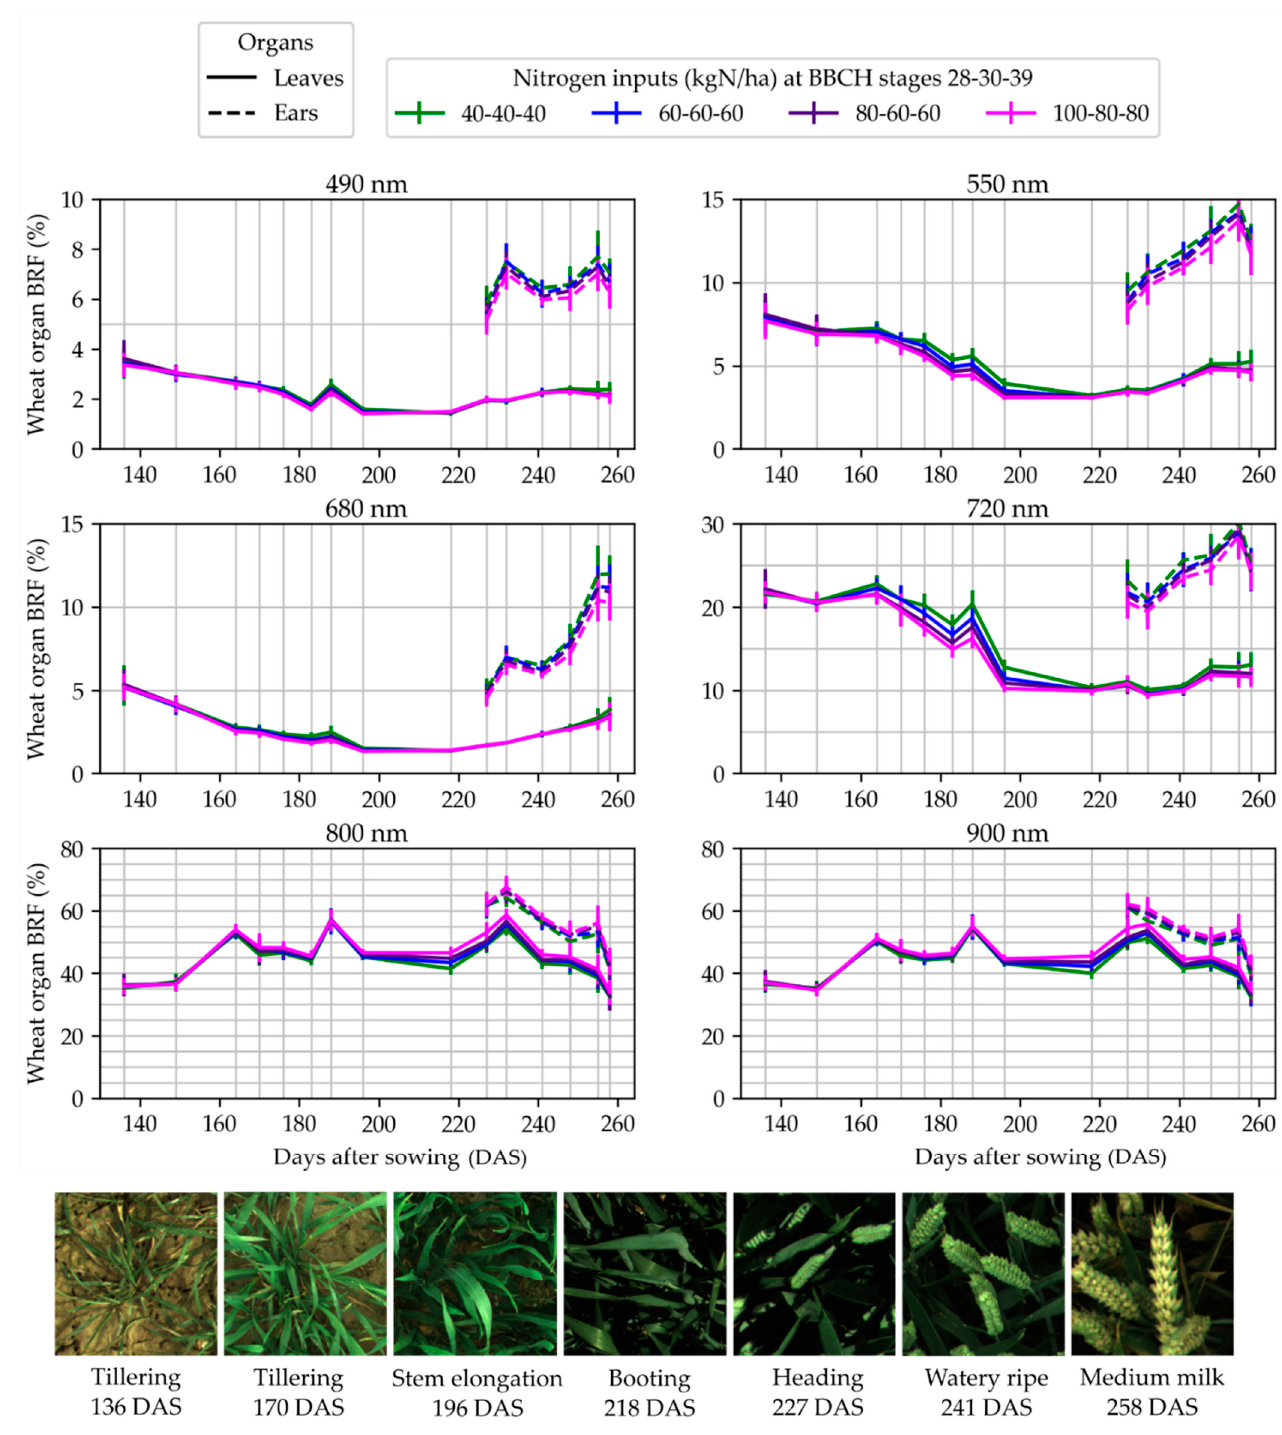
Figure 8. Temporal evolution of the measured bi-directional reflectance factor (BRF) during the measurement campaign in trial 2. The evolution is presented for the six monochrome cameras, designated by the central wavelength of their narrow-band optical filter.